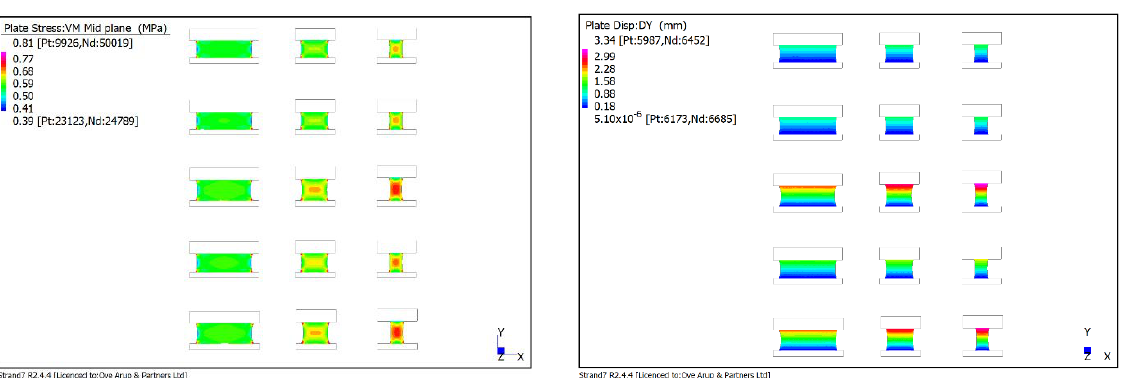
Fig. 17 Silicone analysis – tension load, left- VM plate stress, right- vertical deformations.